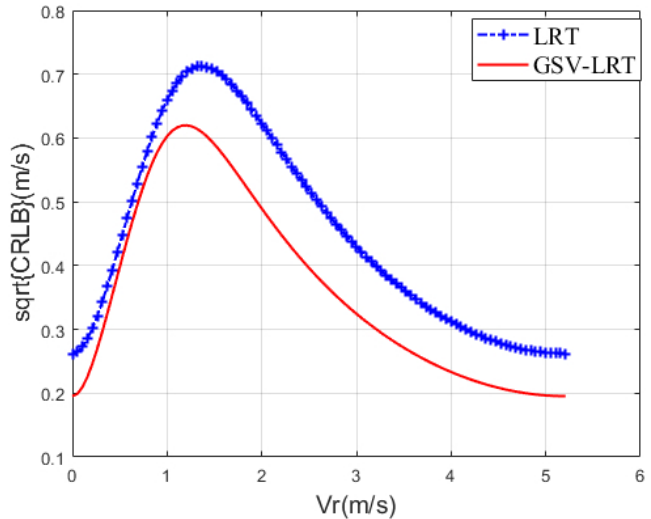
Figure 6. CRBL Curves of the radial velocity, SCR = − 5 dB, CNR = 10 dB, three channels, b1 = 0 m, b2 = 0.15 m, b3 = 0.3 m, β = [ 0.6,0.6,1,0.2,0.2 ] T ⊗ 1 3 .